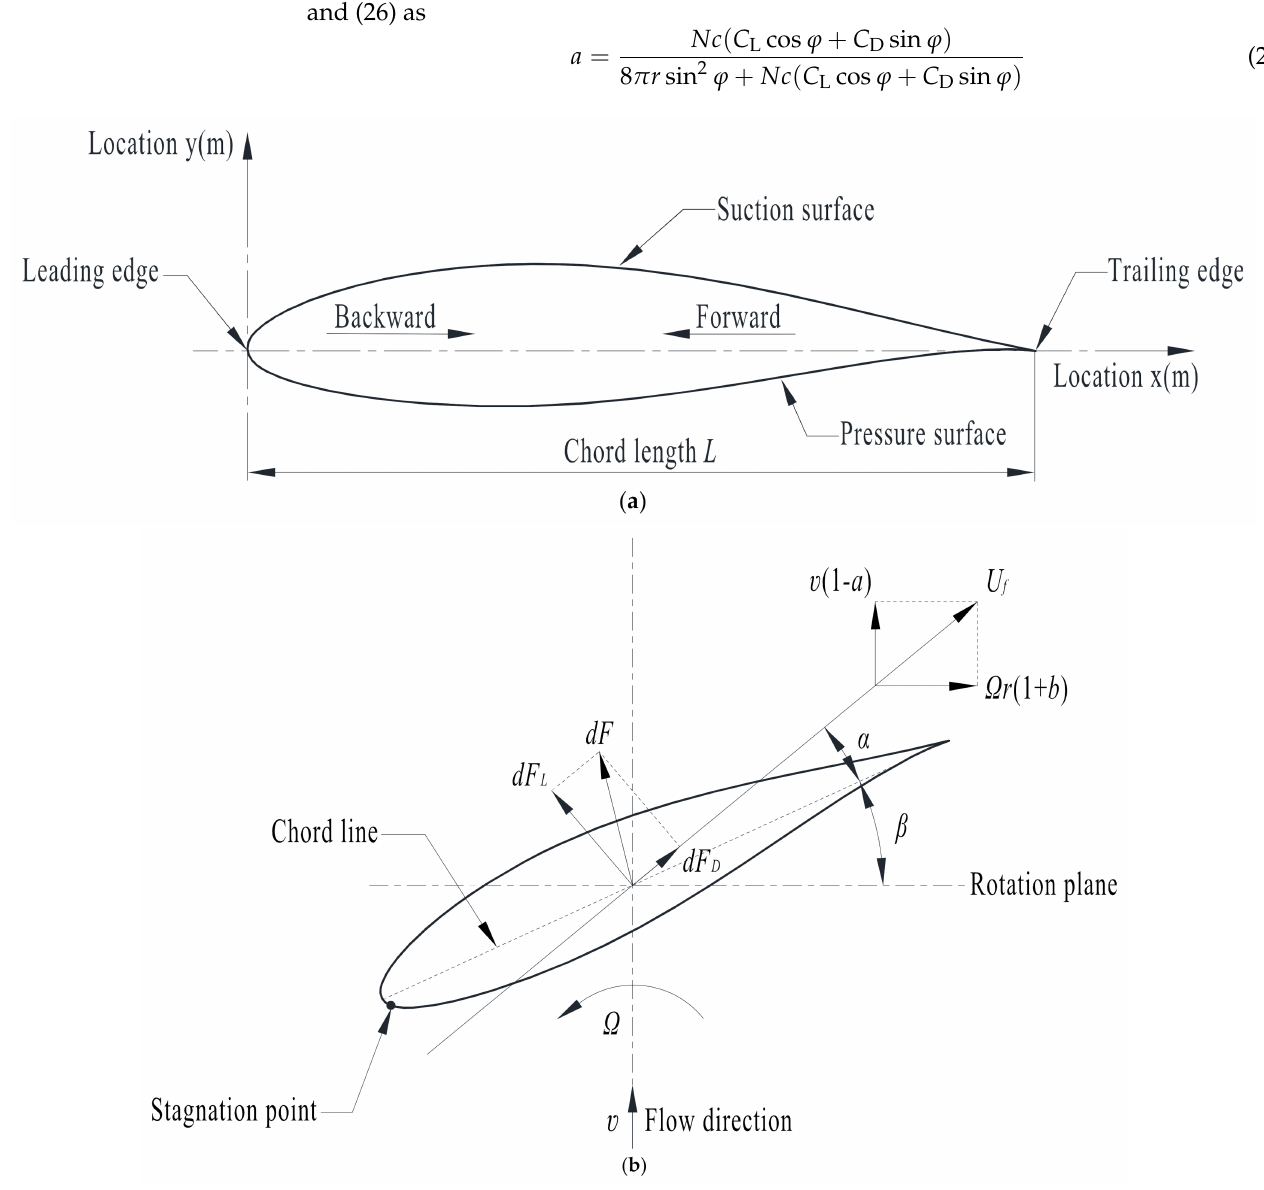
Figure 1. Airfoil parameters: ( a ) geometric parameters and ( b ) hydrodynamic